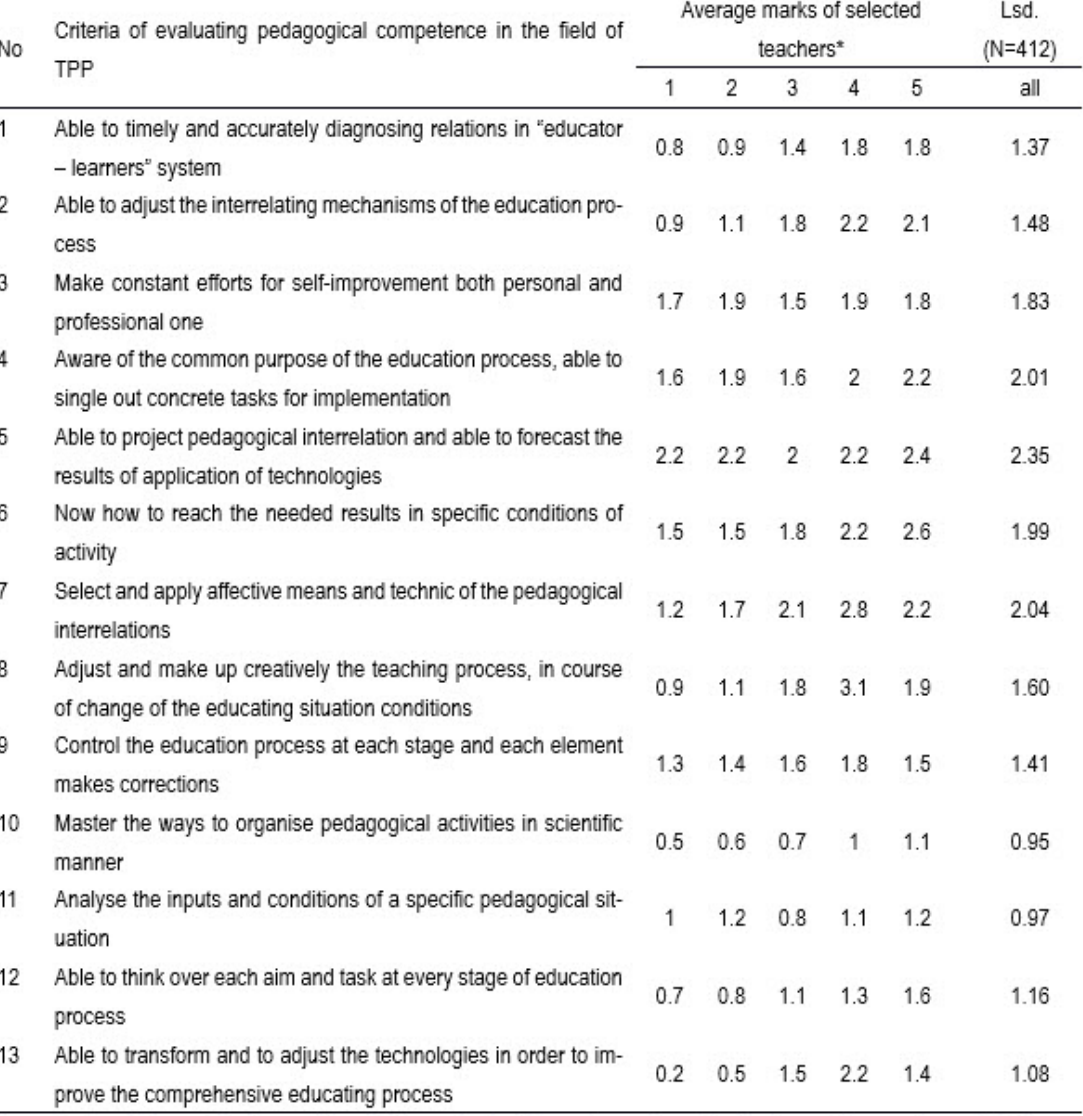
Average estimates of individual criteria for pedagogical abilities for the technologization of the pedagogical process in different selected